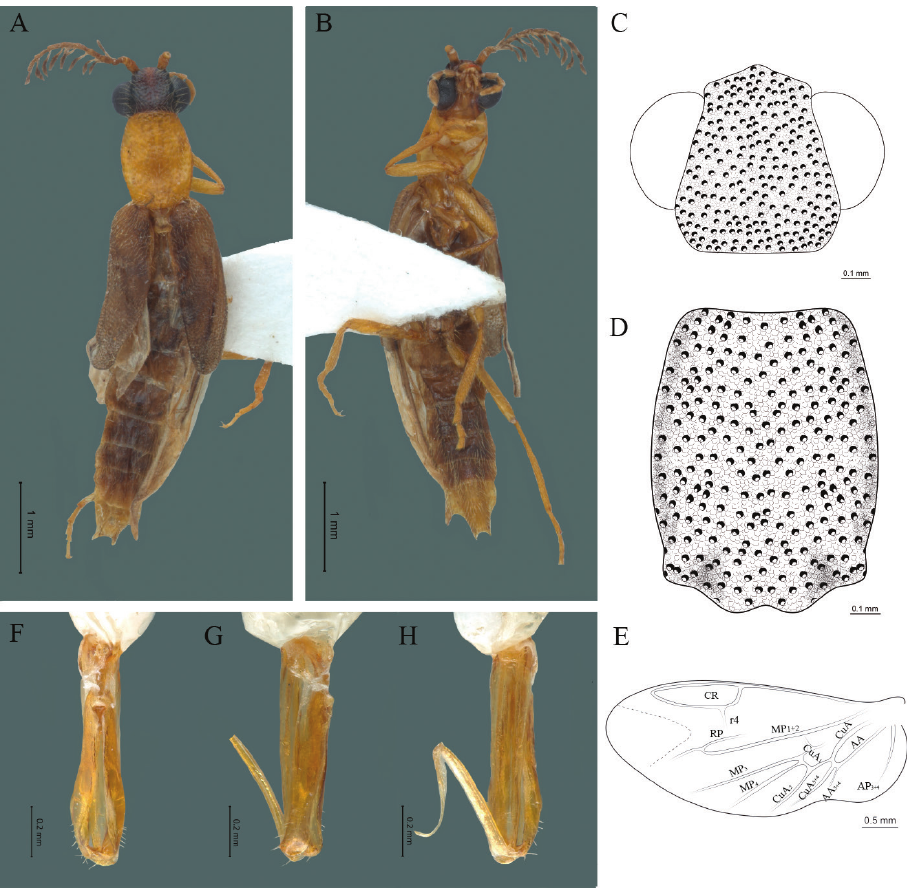
Figure 13. Cenophengus kikapu Vega-Badillo et al. 2021, male. Habitus: A dorsal B ventral C head dorsal D pronotum dorsal E hind wing. Wing venation: CR = Radial Cell; r4 = radial 4 vein; RP = Posterior Radial vein; MP1+2 = Posterior Median vein; CuA = Cubital; AA and AP = Anterior and Posterior Anal veins. Aedeagus: F dorsal view G lateral view H ventral